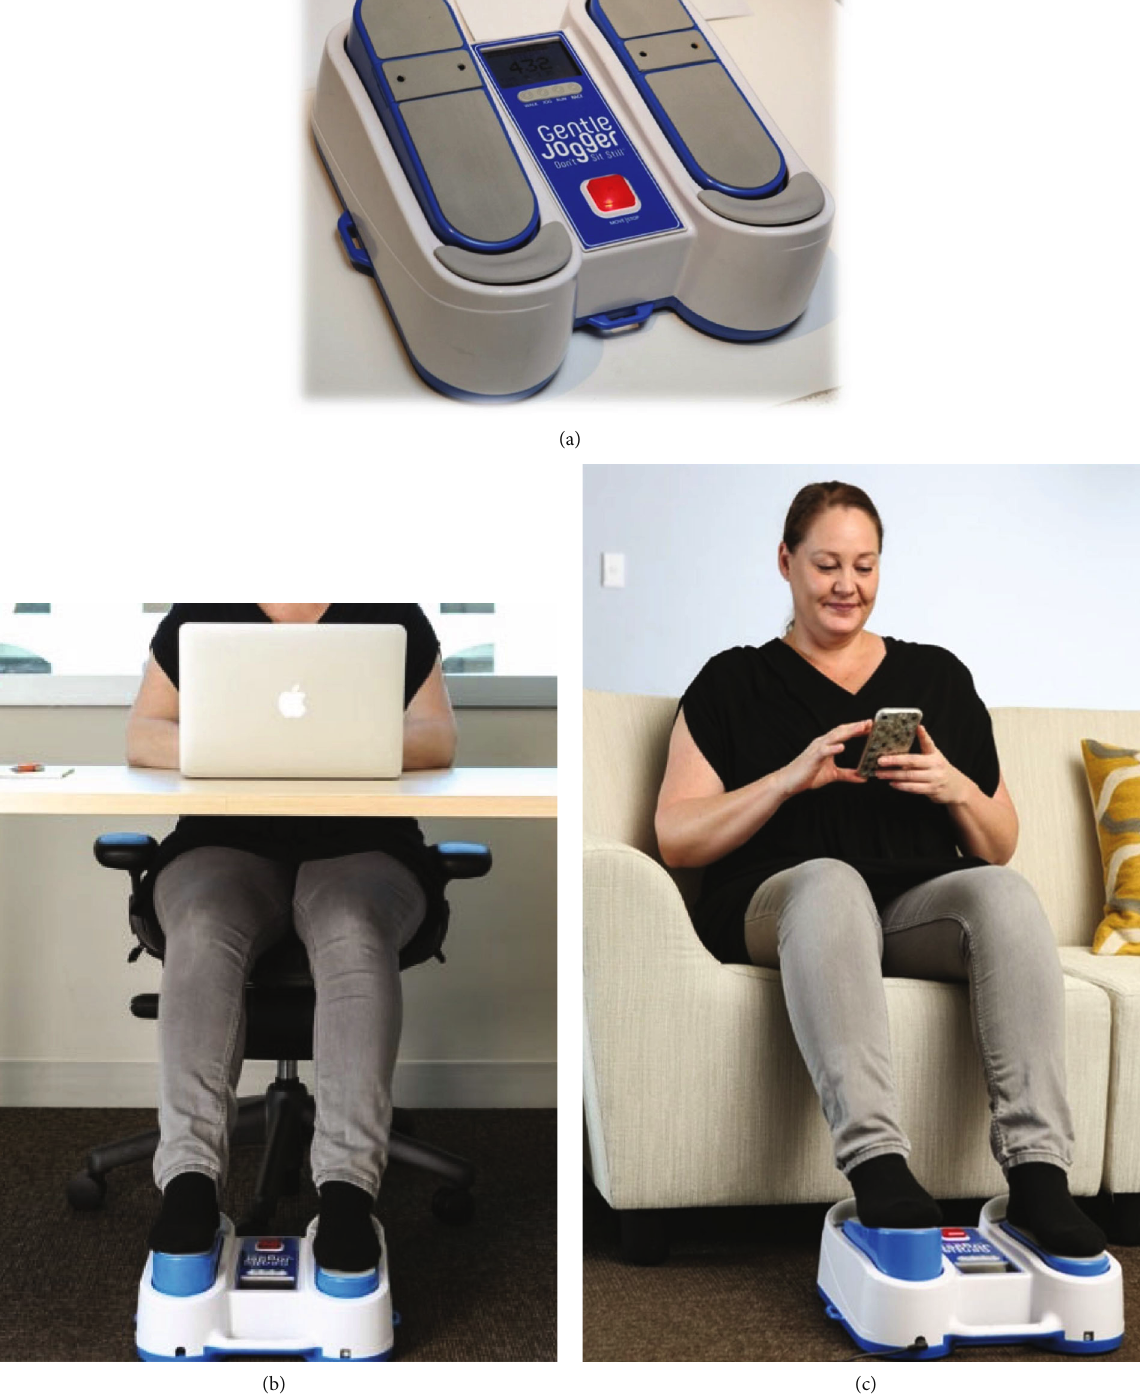
Figure 1: Photographs of the passive simulated jogging device (JD). The photograph depicts a close-up of the JD (a), a seated subject multitasking and working on a desk (b), and a seated subject on a couch (c) with the feet on the passive simulated jogging device